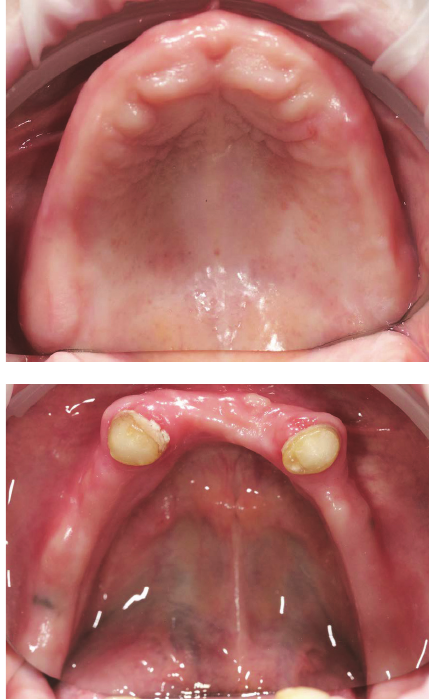
Figure 1: Clinical condition.